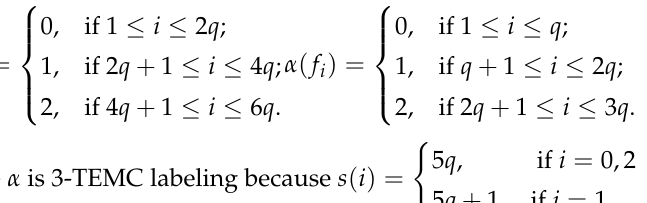
Figure 14. 3-TEMC labeling of F 3